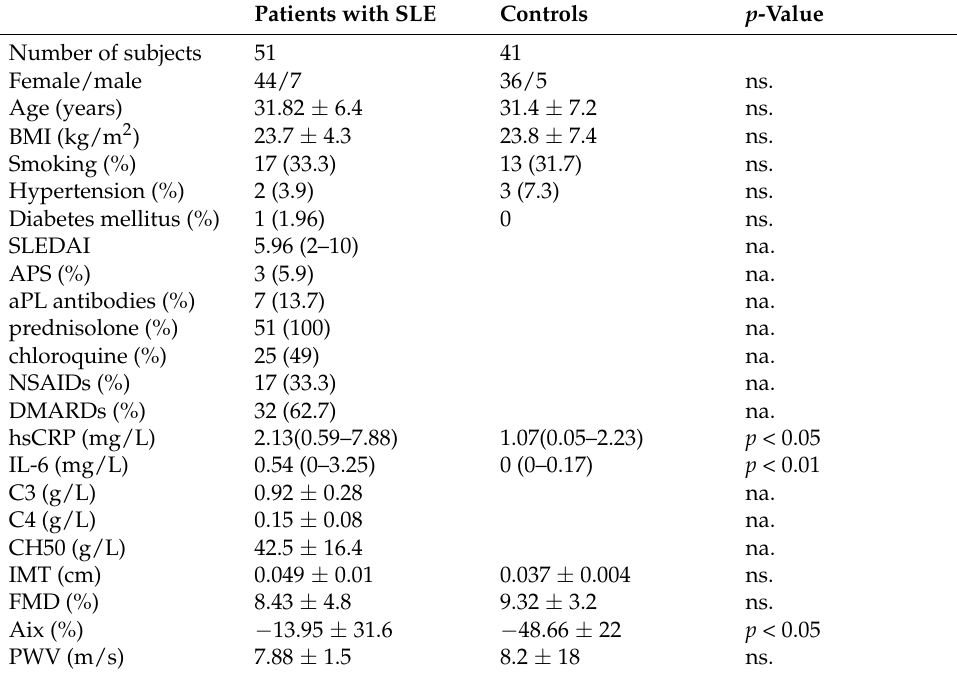
Table 1. Anthropometric and clinical data, inflammatory parameters, and vascular damage tests of study individuals. Values are presented as mean ± standard deviation or median (lower quartile– upper quartile). Patients with SLE Controls p